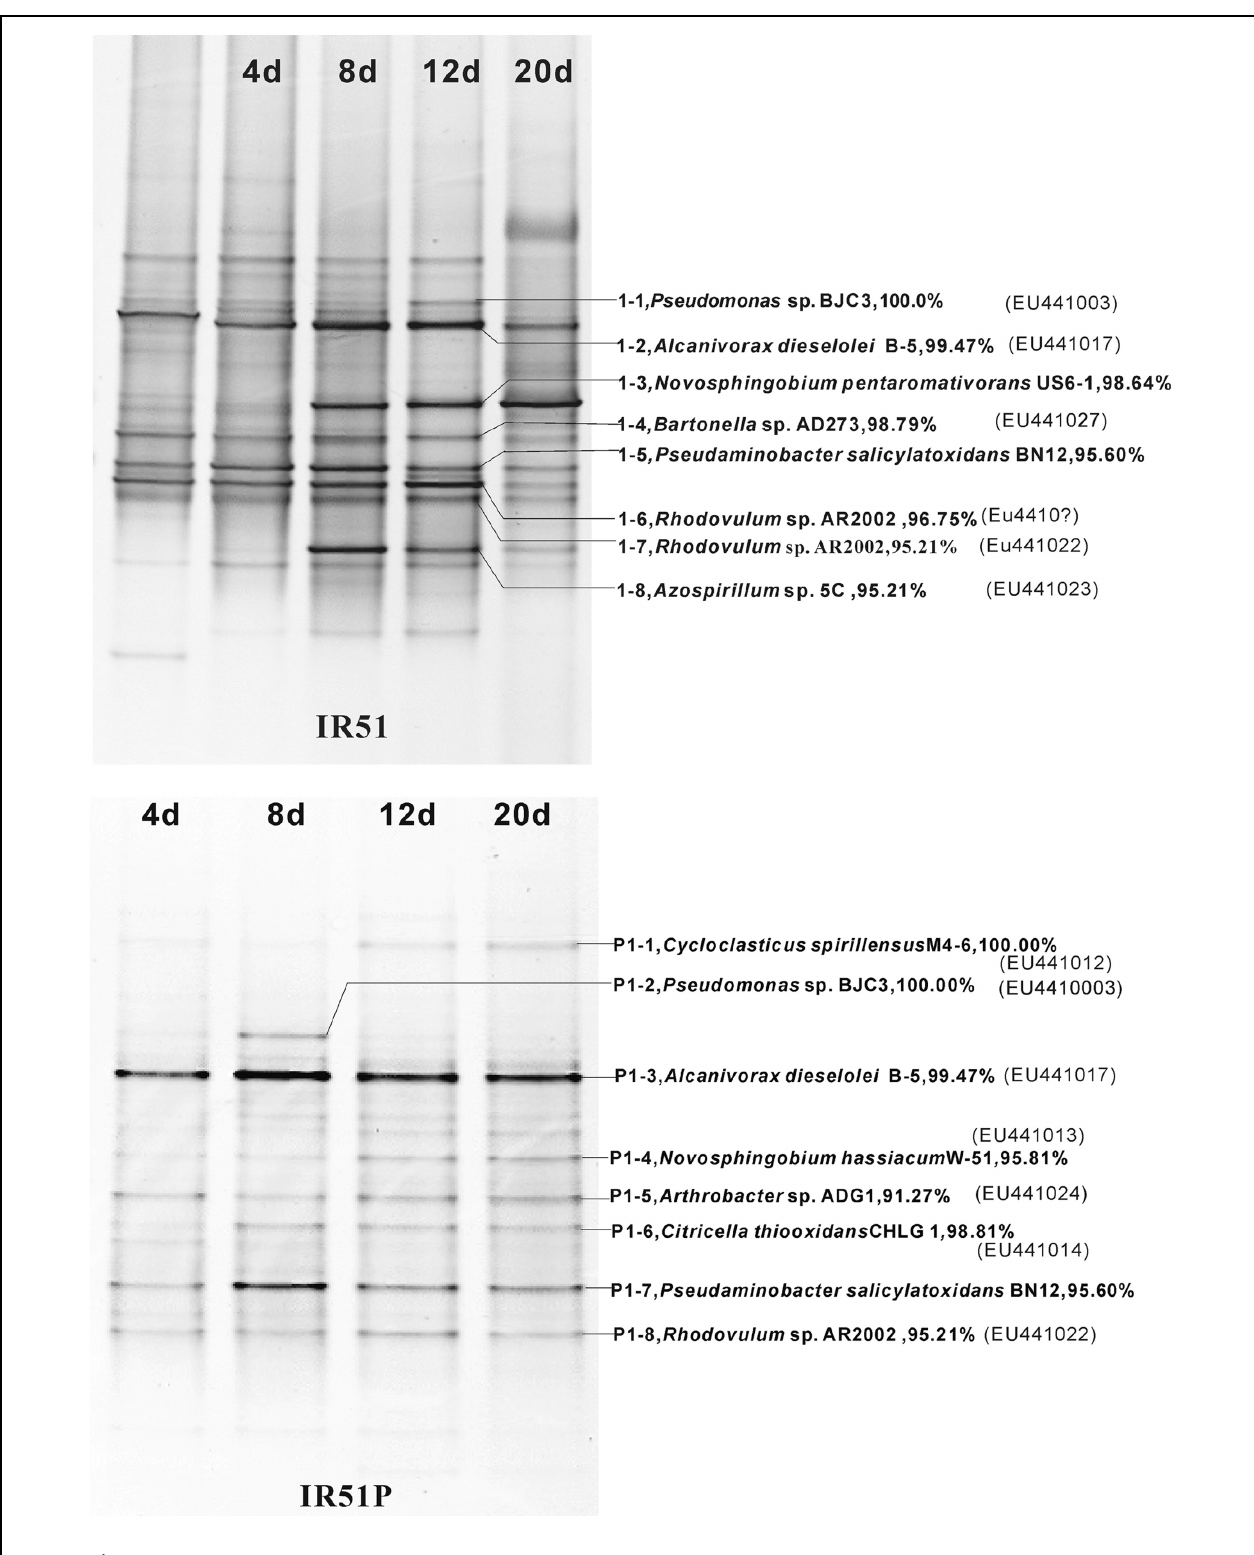
inoculum of the last transfer. The closest described relatives in GenBank of the main bands in profiles are labeled at the right. (Top) , IR51grown with 4-PAH mixture; (Bottom) , IR51P grown with